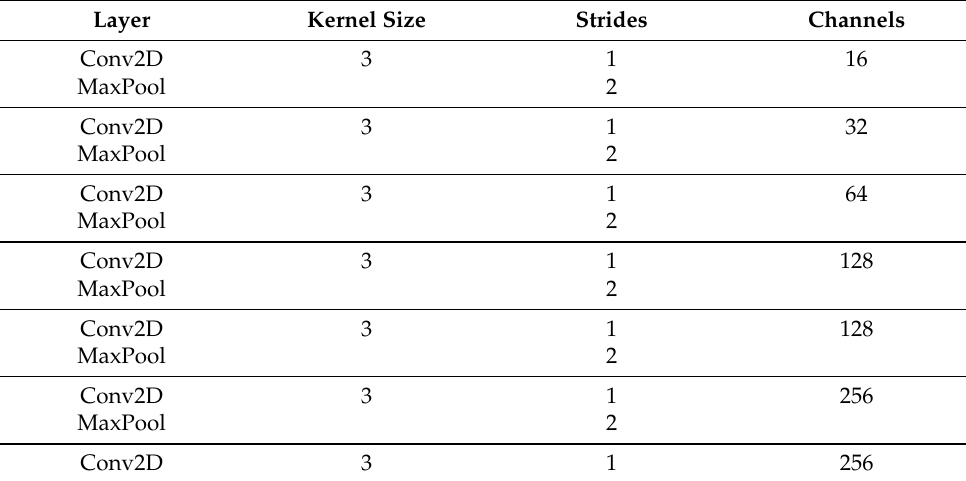
Table 1. Structure of CNN. Layer Kernel